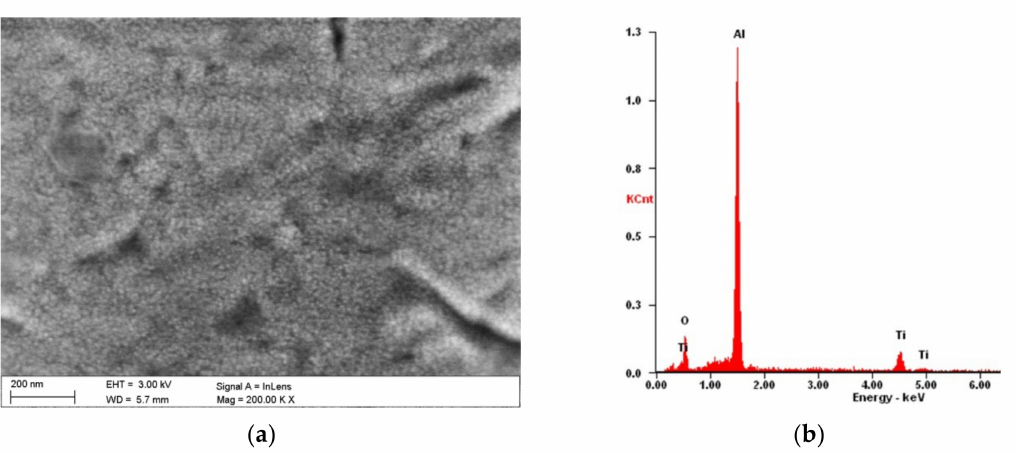
Figure 2. Morphology of TiO 2 /nanoTiO 2 bimodal coating on Al-Si-Cu alloy substrate: ( a ) SEM image and ( b ) X-ray energy-dispersive plot of the area shown in ( a